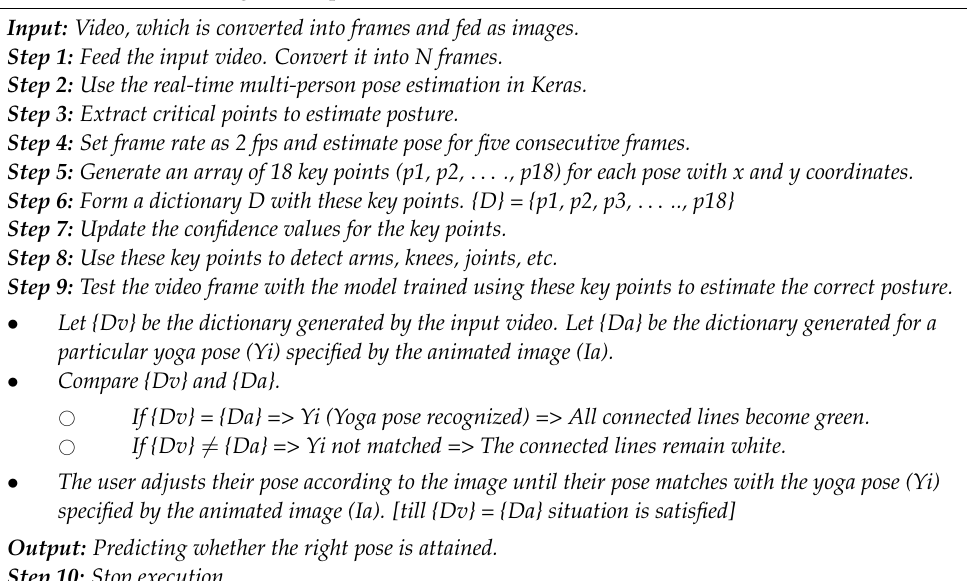
Algorithm 1: Estimating correct